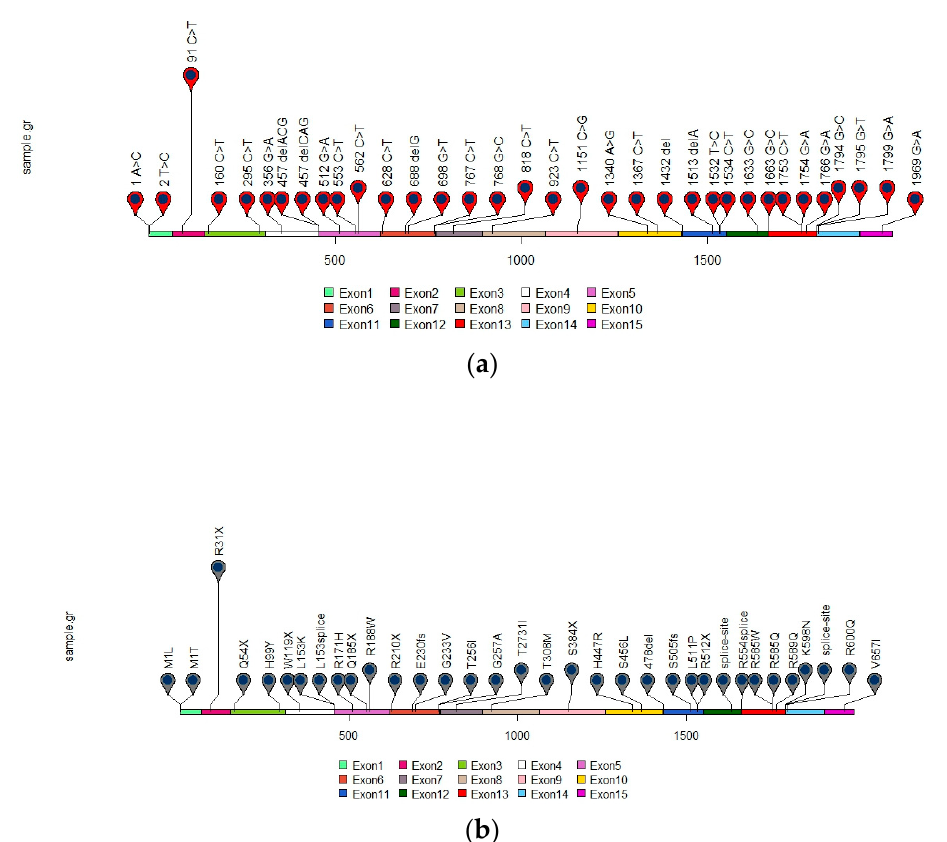
Figure 2. Distribution of reported SDHA gene mutations in GIST. Mutations are annotated at the cDNA ( a ) and protein level ( b ).